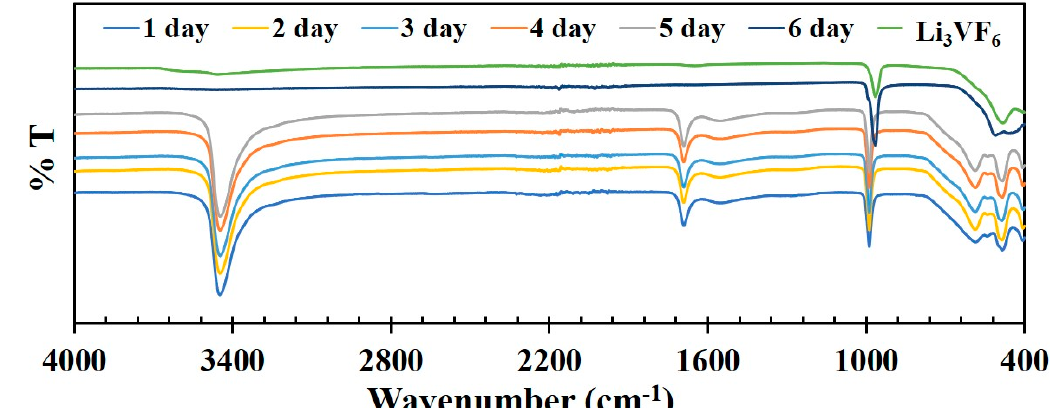
Figure 4. FT-IR spectra of the compounds synthesized from 1 to 6 days.